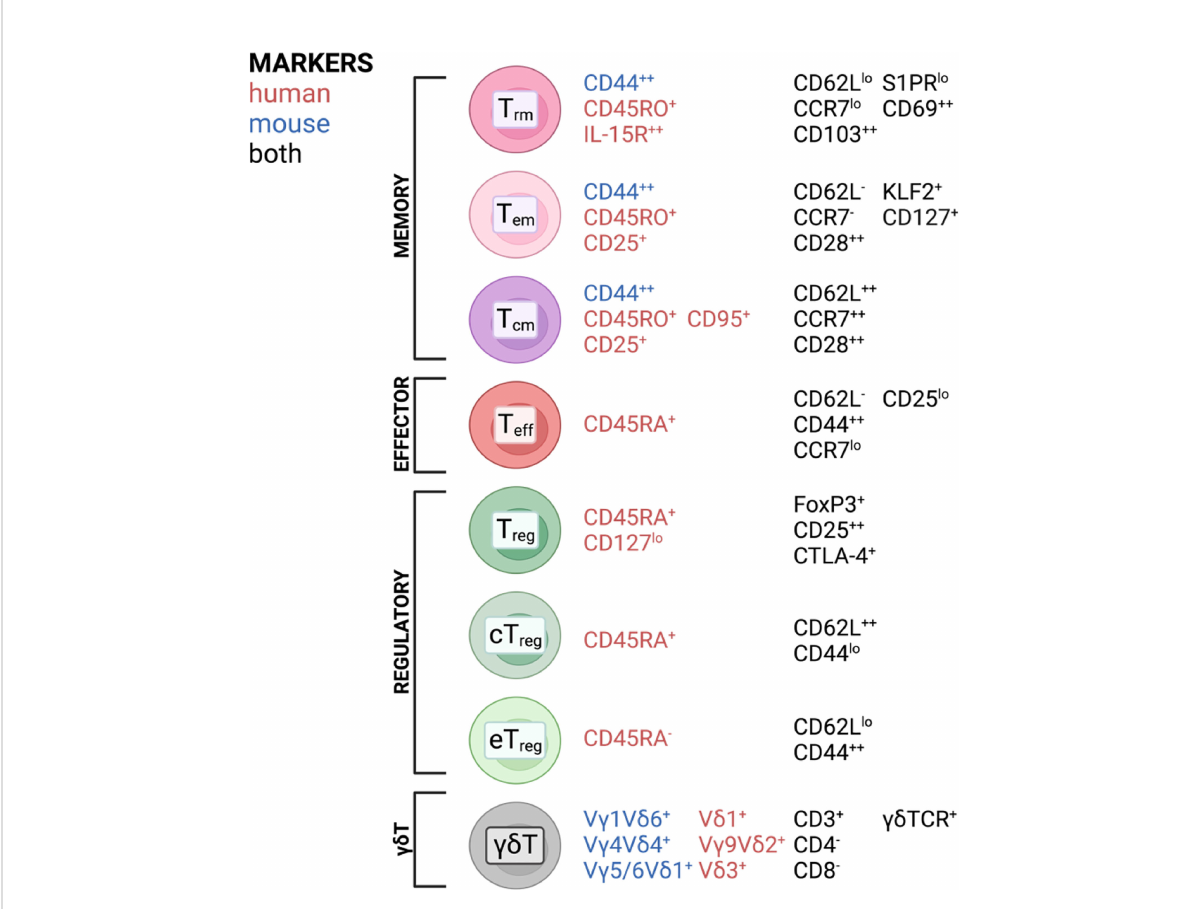
FIGURE 1 T cell subsets and commonly associated markers in mice and humans found in barrier tissues discussed in this review. Created with